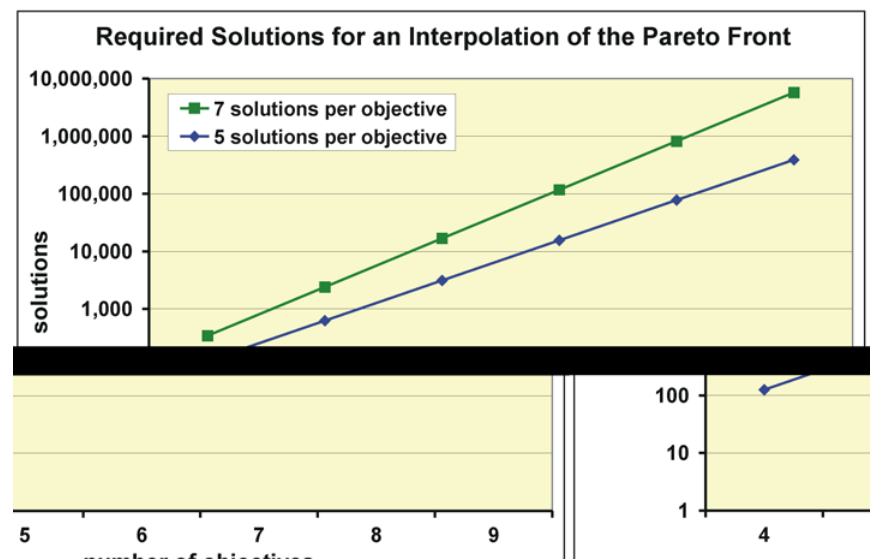
Figure 9. The number of required data points (Pareto-optimal solutions) of an approximation of a Pareto front increases exponentially with a growing number of conflicting objectives. The green line is based on a resolution of 7 data points per additional objective (axis), while the blue one uses 5